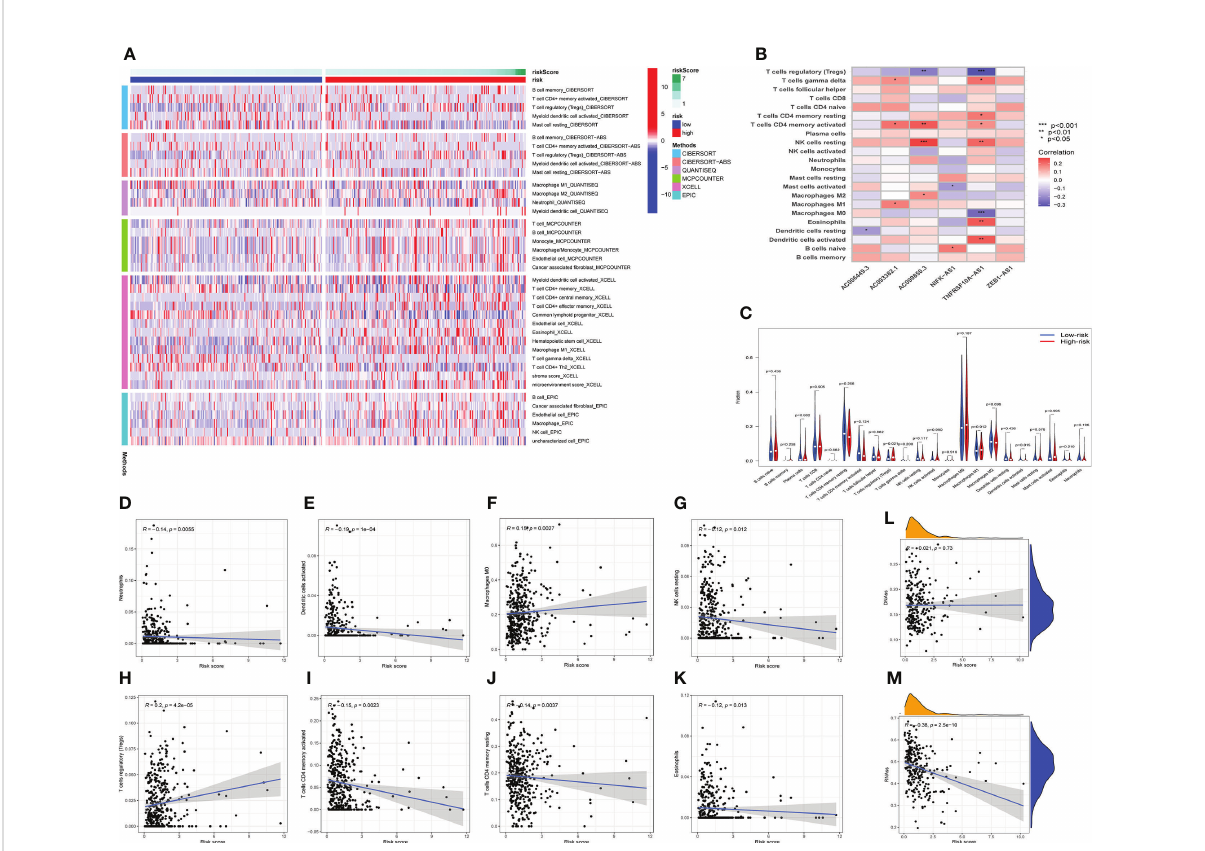
FIGURE 6 The immune landscape analysis. (A) The immune landscapes of high-risk and low-risk groups. (B) The correlation between CRLs and different immune cells, AC099850.3 had the highest positive correlation with resting NK cells, and TNFRSF10A-AS1 had the highest negative relation with T cells regulatory and macrophages M0. (C) The variations of immune cell in fi ltration levels between the high-risk and low-risk groups. (D – K) Analysis of the Pearson correlation between distinct immune cells and risk scores. (L, M) The correlation between DNA stem cell score (DNAss), RNA stem cell score (RNAss), and risk score. * P < 0.05, ** P < 0.01, *** P <